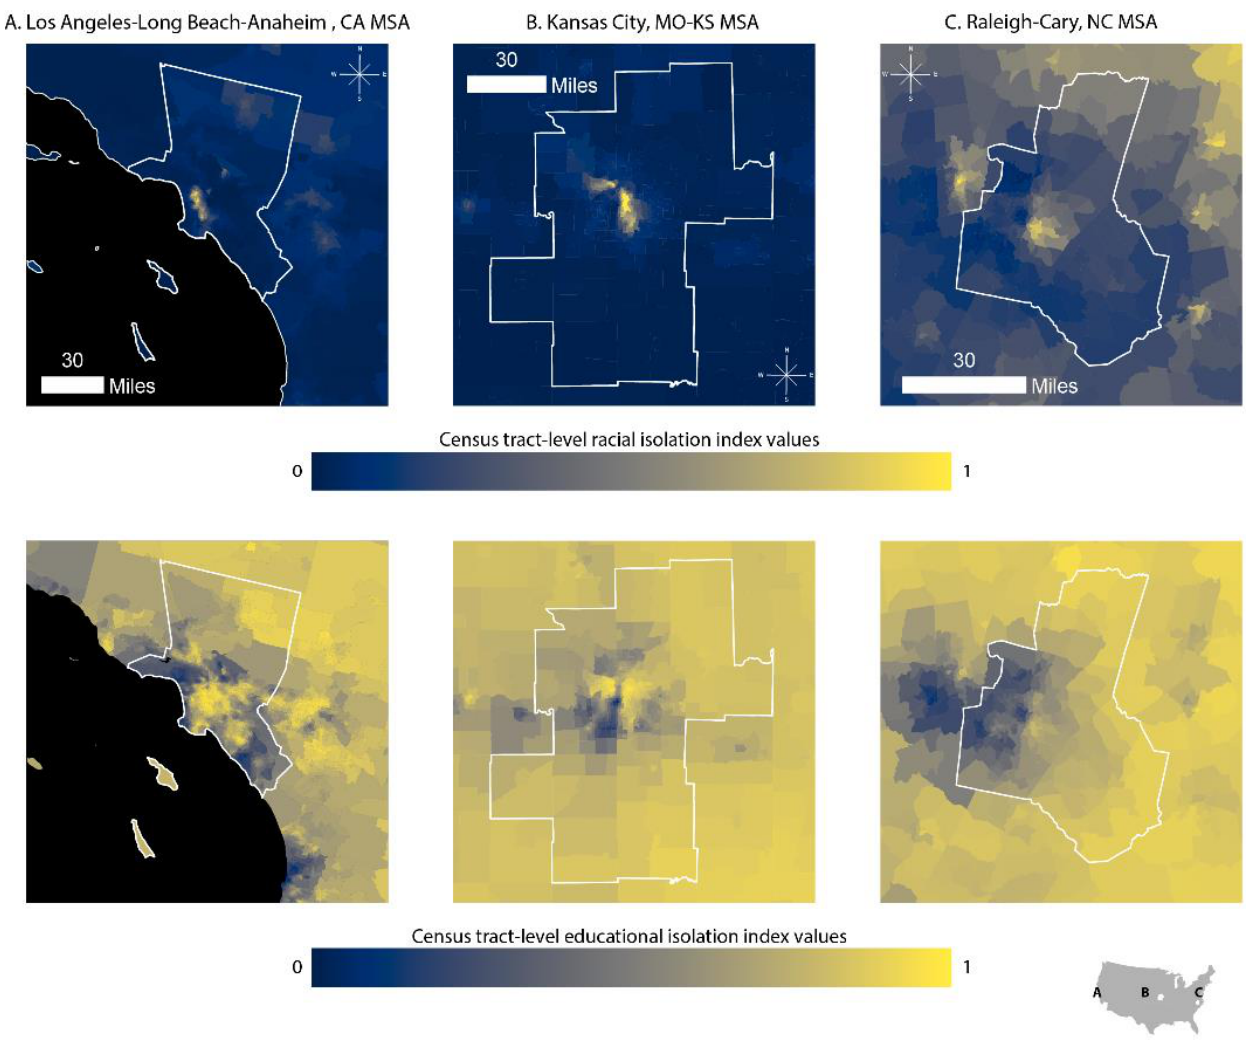
Figure 2. Census-tract level RI and EI in three MSAs: Los Angeles-Long Beach-Anaheim (Panel A ); Kansas City (Panel B ); and Raleigh-Cary (Panel C ). RI ranges from 0 to 1. A value of 0 indicates that the neighborhood environment (defined as the index tract and tracts adjacent to the index tract) is entirely composed of non-NHB individuals. A value of 1 indicates that the neighborhood environment is entirely composed of NHB individuals. EI also ranges from 0 to 1. A value of 0 indicates that the neighborhood environment is entirely composed of individuals with a four-year college degree. A value of 1 indicates that the neighborhood environment is entirely composed of non-college educated individuals. Each MSA is projected to the appropriate projected coordinate system for its location in space, specifically: (Panel A ) NAD 1983 State Plane California V FIPS 0405 Feet; (Panel B ) North American Datum (NAD) 1983 Universal Transverse Mercator (UTM) Zone 14N; (Panel C ) NAD 1983 State Plane North Carolina FIPS 3200 Feet.